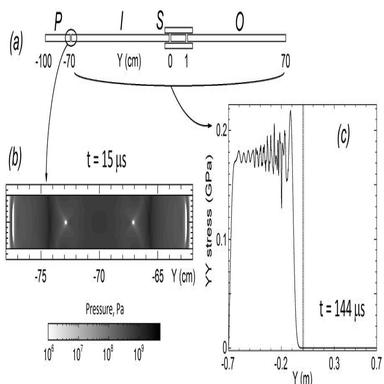
Example of the SHPB calculation: schematic of the numerical setup (a); pressure map of the striker-input bar impact interface region (b); and axial stress from the outer bar surface before sample loading (c).